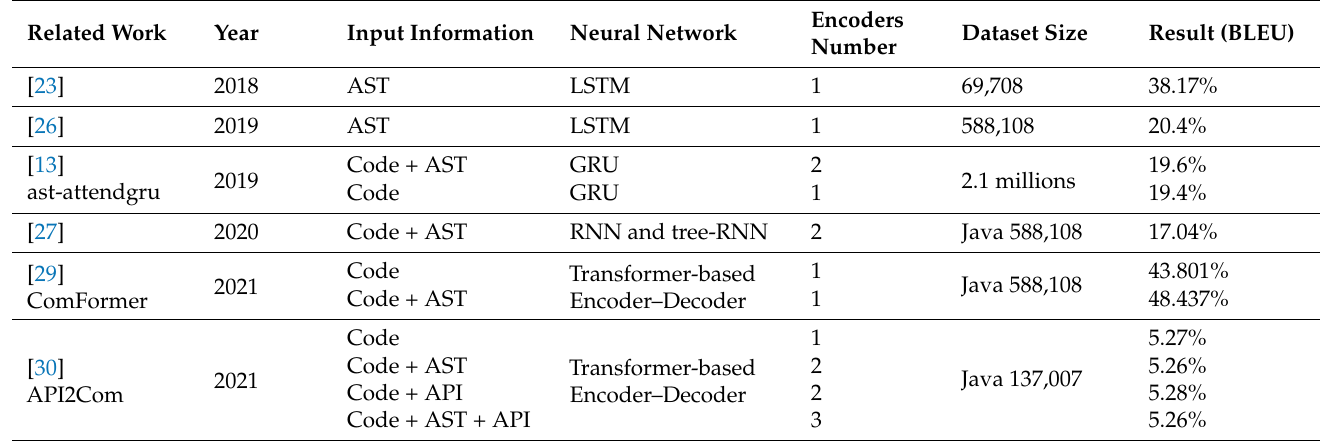
Table 1. Comparison of Java code comment generation